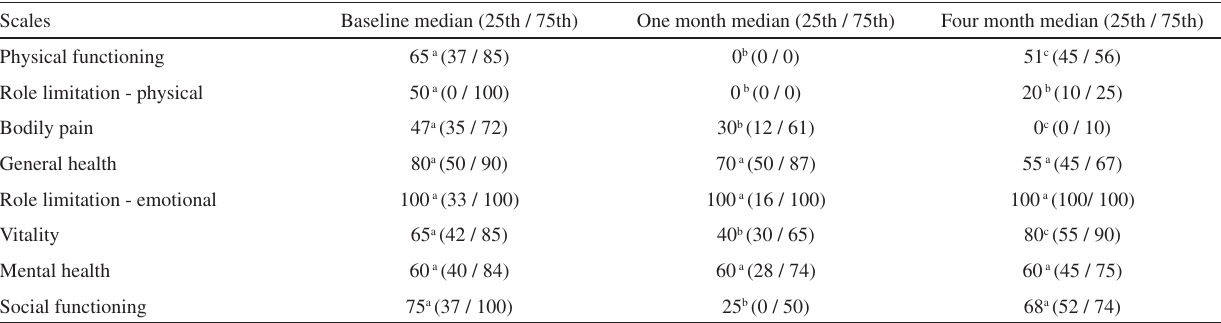
Table 2 - SF-36 scores (median and percentiles) in patients with hip fractures at baseline, one month and four month follow-up